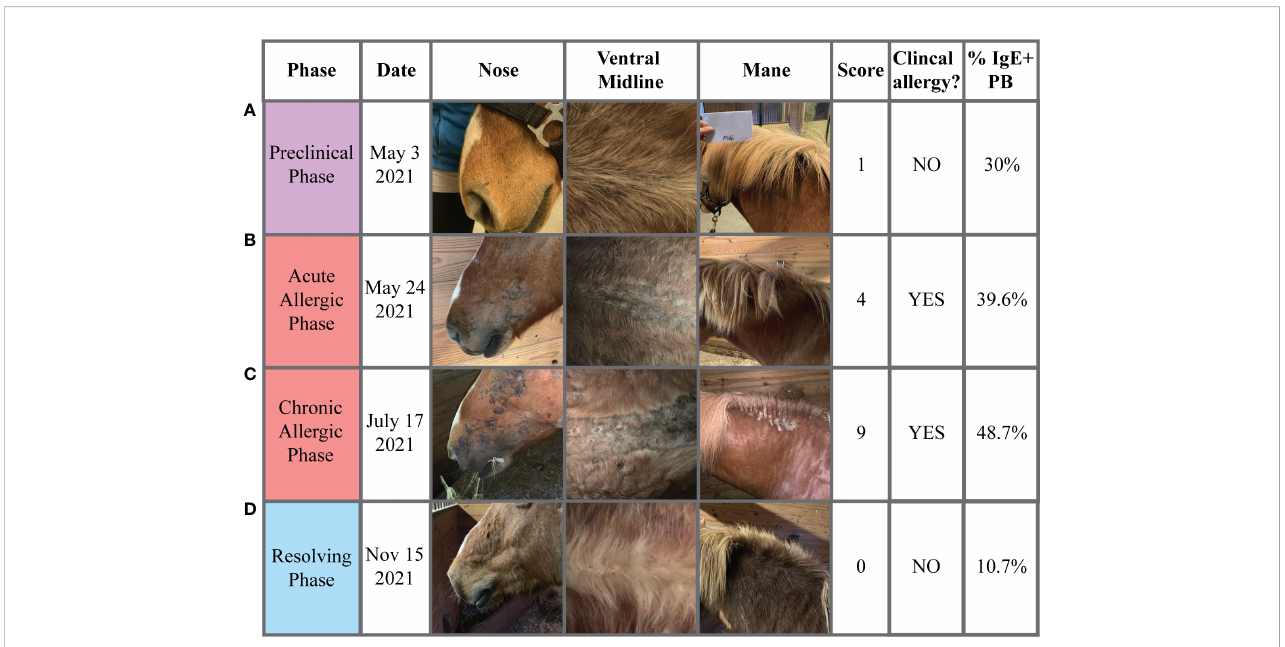
FIGURE 3 Progression of clinical signs of allergy. Photographs of each horse were taken to document changes in clinical signs of allergy ( Cul hypersensitivity) at each phase of allergen exposure (Preclinical, Allergic, Resolving). Pictures from one allergic horse with common skin lesion and hair loss sites at the face/ nose, ventral midline and mane/neck are shown. The clinical allergy score (0-10), whether the signs were considered clinical allergy (yes/no), and IgE+ plasmablast frequencies (%) were also reported for each timepoint. (A) The Preclinical Phase (May 3) when insects and midges were present in the environment and IgE + plasmablasts were above the threshold of 12% in allergic horses. (B) The start of the Allergic Phase (May 24) when allergic horses fi rst started to develop acute clinical disease. (C) The middle of the Allergic Phase (June 17) when allergic horses were experiencing consistent allergen exposure, sustained IgE + plasmablast frequencies in peripheral blood, and severe chronic clinical disease. (D) The end of the Resolving Phase (November 15) when midges had died and were no longer present in the environment and all allergic horses had clinically recovered. Pictures are representative from one of seven allergic